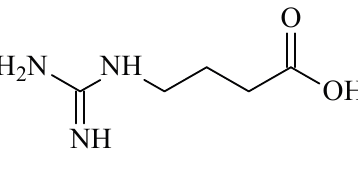
Figure 15. 4–Guanidinobutyric